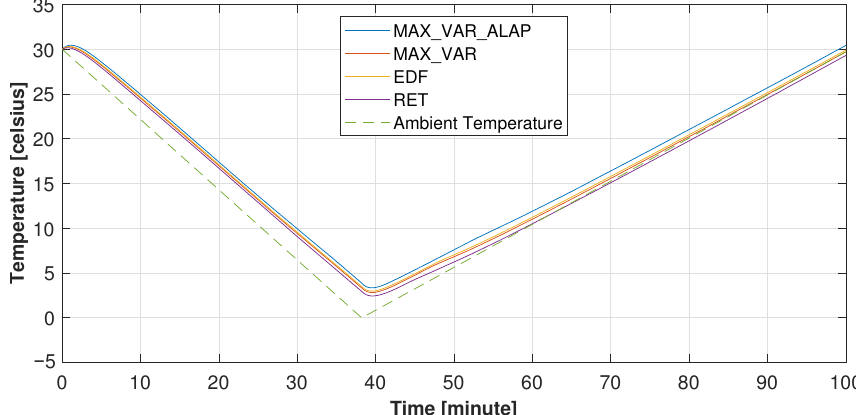
Figure 7. Simulated battery internal cell temperature profile at for U =